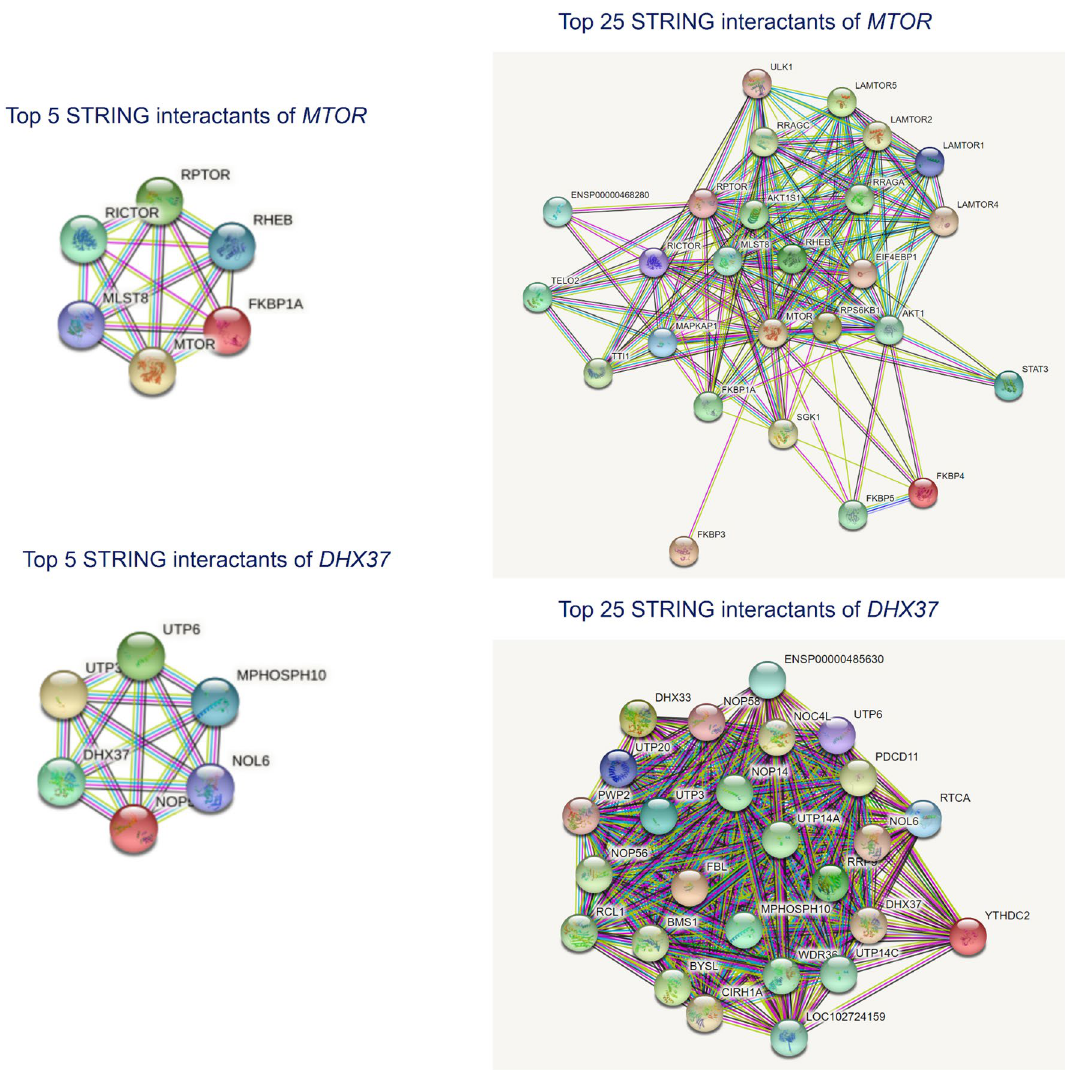
Figure 5. Interacting proteins analysis from STRING Interaction Network. The top 5 and 25 STRING interactants of both MTOR and DHX37 genes are shown in this